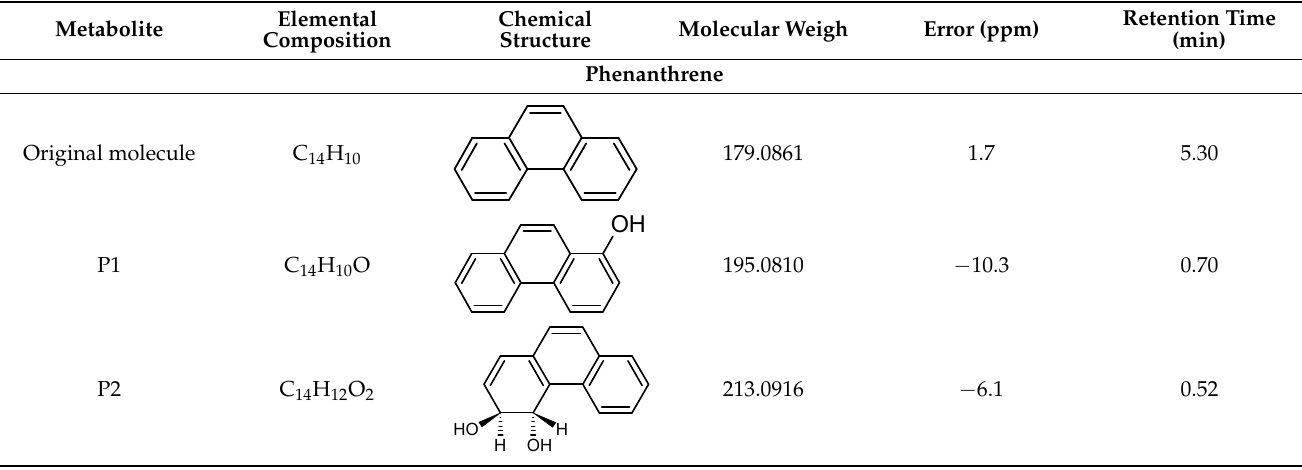
Table A1. Phenanthrene and benz( α )anthracene metabolites after fungal biodegradation.